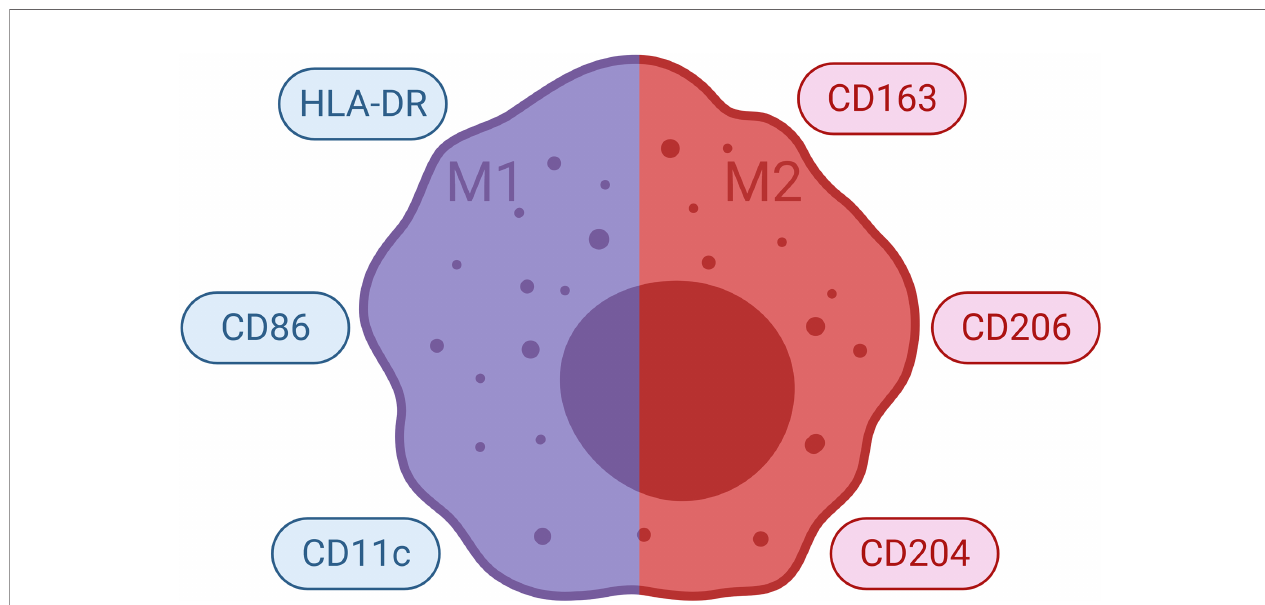
FIGURE 7 | Commonly Used Markers for Macrophages. Selected markers used to distinguish macrophage phenotypes are demonstrated. HLA, human leukocyte antigen.